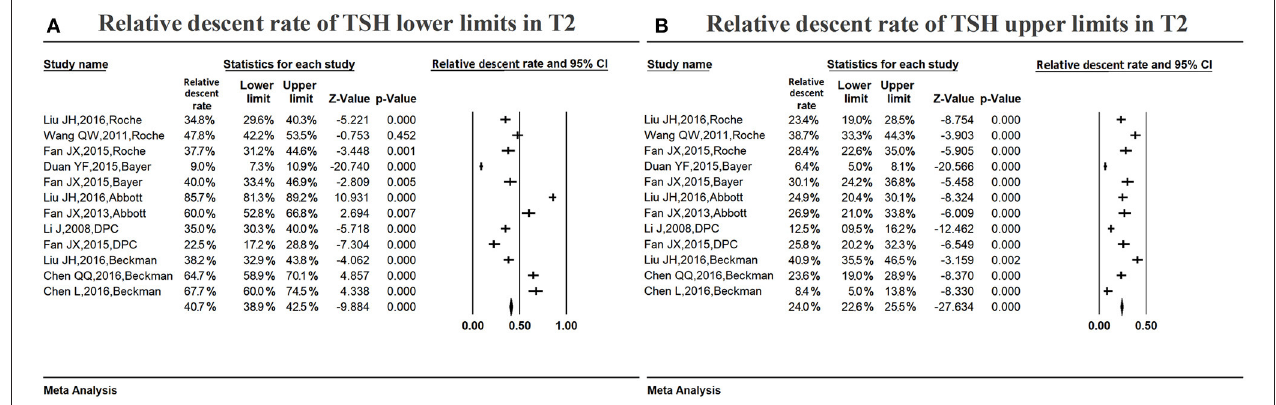
FIGURE 5 | Meta-analysis of relative descent rate of TSH lower (A) and upper (B) reference limits in middle pregnancy. Figure shows unadjusted relative descent rate of TSH lower (A) and upper (B) limit estimates in middle pregnancy with 95% confidence limits for each study selected. Pooled relative descent rate estimates are represented as diamonds in this plot.